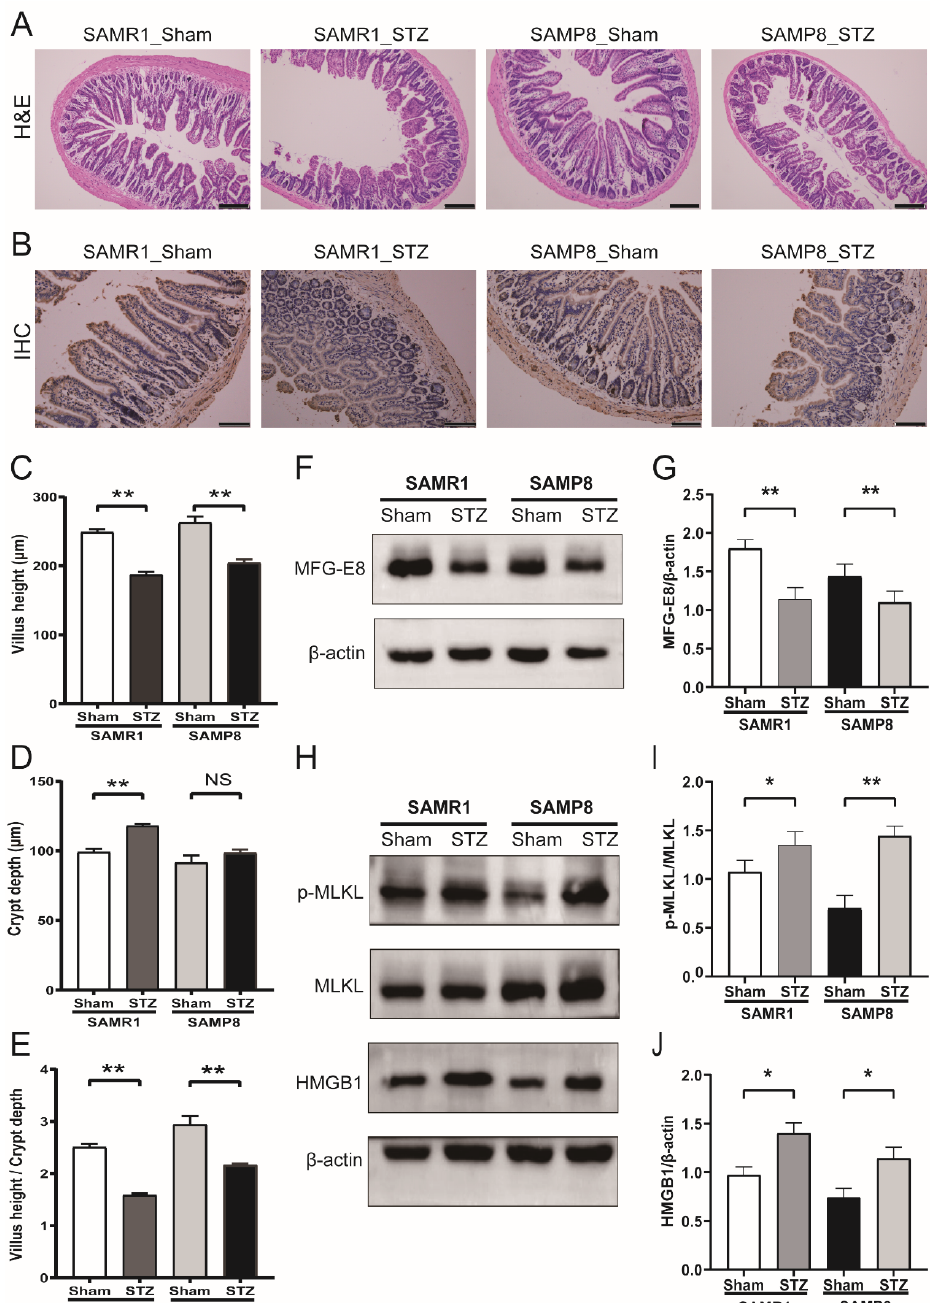
Figure 2. Histological findings and the protein expression of MFG-E8, p-MLKL and HMGB1 in the intestinal. ( A ) Representative H&E staining of terminal ileum section was assayed (scale bar: 200 um, n = 5 per group). ( B ) Immunohistochemical staining for protein localization of MFG-E8 (scale bar: 100 um, n = 5 per group). ( C – E ) Intestinal villus height, crypt depth, and the ratio between the two were measured in each group to evaluate the intestinal morphology ( n = 5 per group). ( F – J ) Western blot and densitometric analyses of MFG-E8, p-MLKL, and HMGB1 protein expression in the small intestine of the four groups. * p < 0.05, ** p < 0.01 vs. SAMR1/SAMP8 control group. NS: no statistical